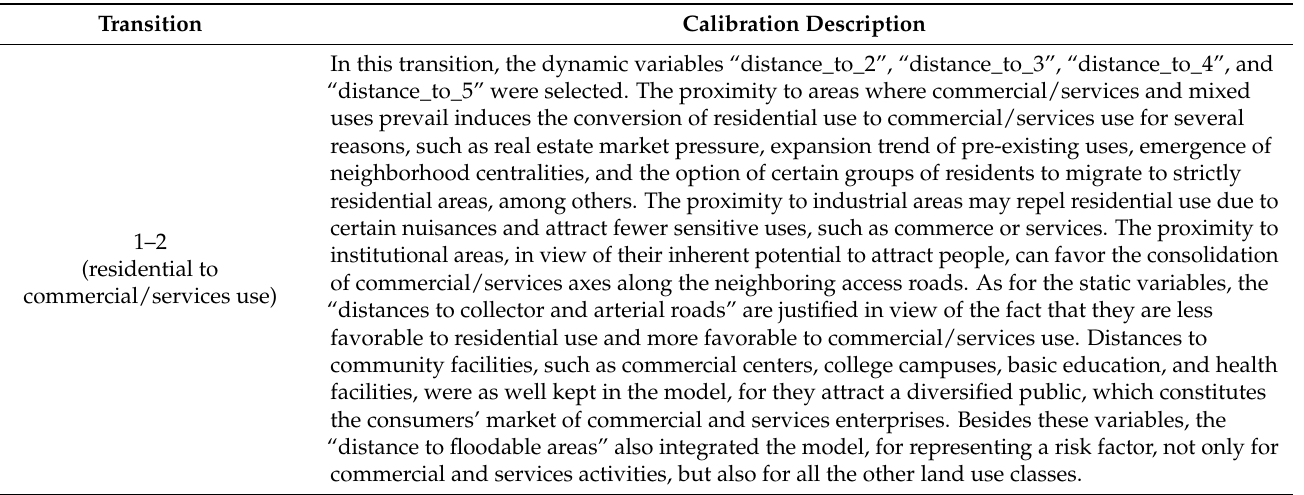
Table 8. Observed transitions from 2006 to 2018 and variables used for